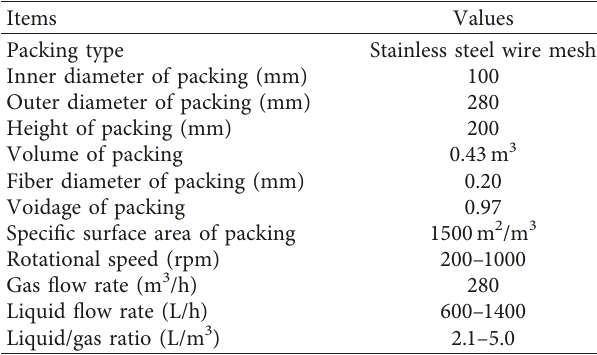
Figure 1: Schematic diagram of the experimental system. 1: diesel engine; 2, 3, and 5: gas flowmeters; 4: SO liquid flowmeter; 8: regulating valve; 9 and 13: pumps; 10: RPB reactor; 11: pH electrode; 12: scrubbing solution; 14: alkaline solution; 15: gas analyzer; 16: three-way valve. Table 1: The specifications and operating conditions of the RPB